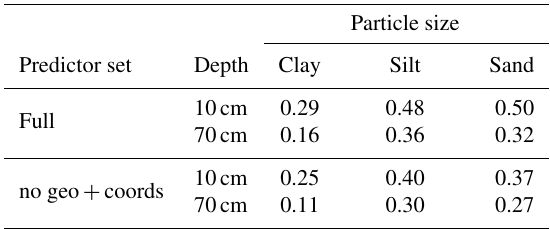
Table 3. Model performance in R 2 for three texture classes at two depth levels and for two predictor